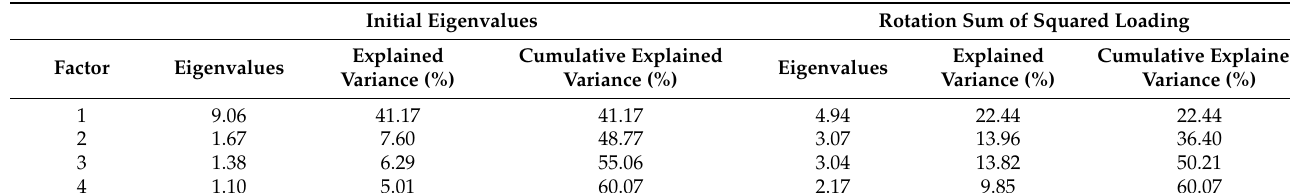
Table 2. Eigenvalues and Explained Variances of BWAQ factors.